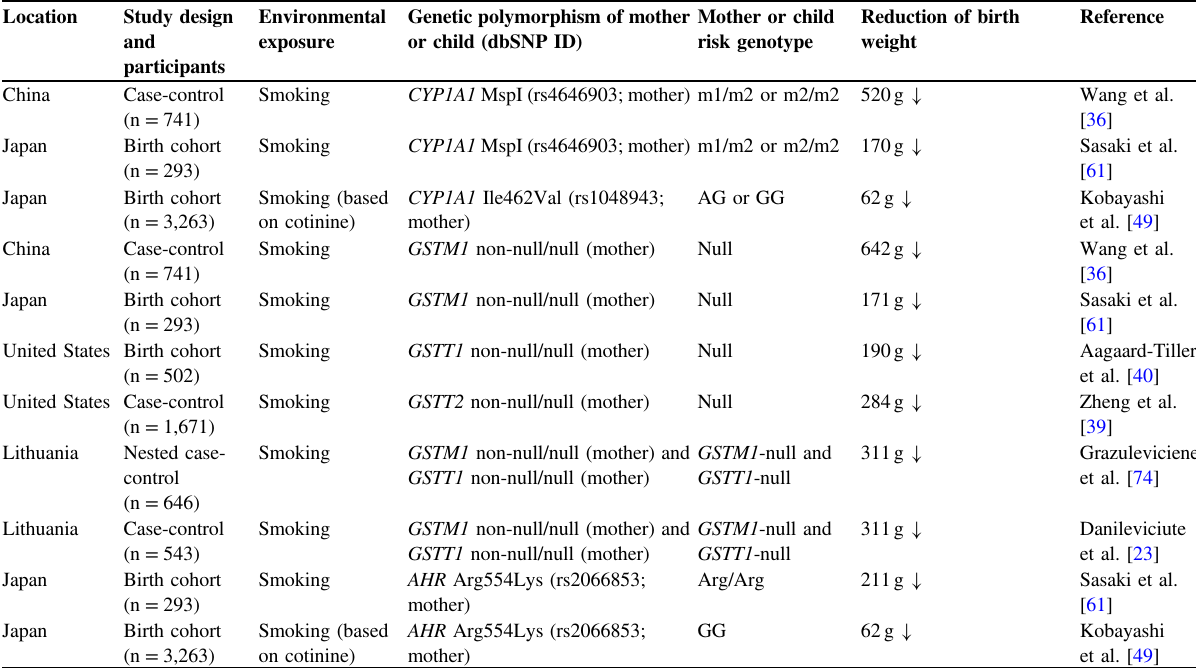
Table 1 Maternal smoking during pregnancy and associated reduction of birth weight Location